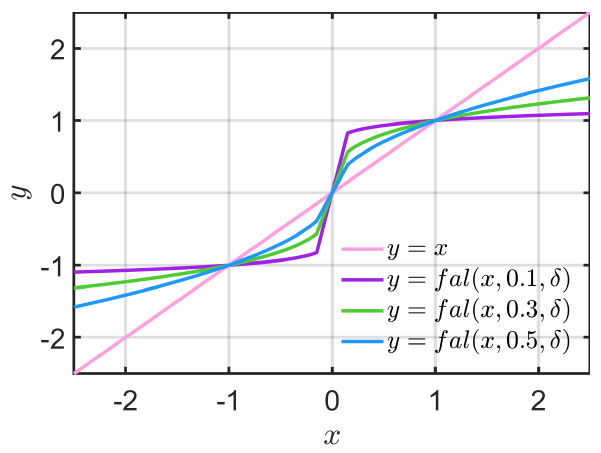
Figure 2. Comparison of the linear and nonlinear f al functions with different α